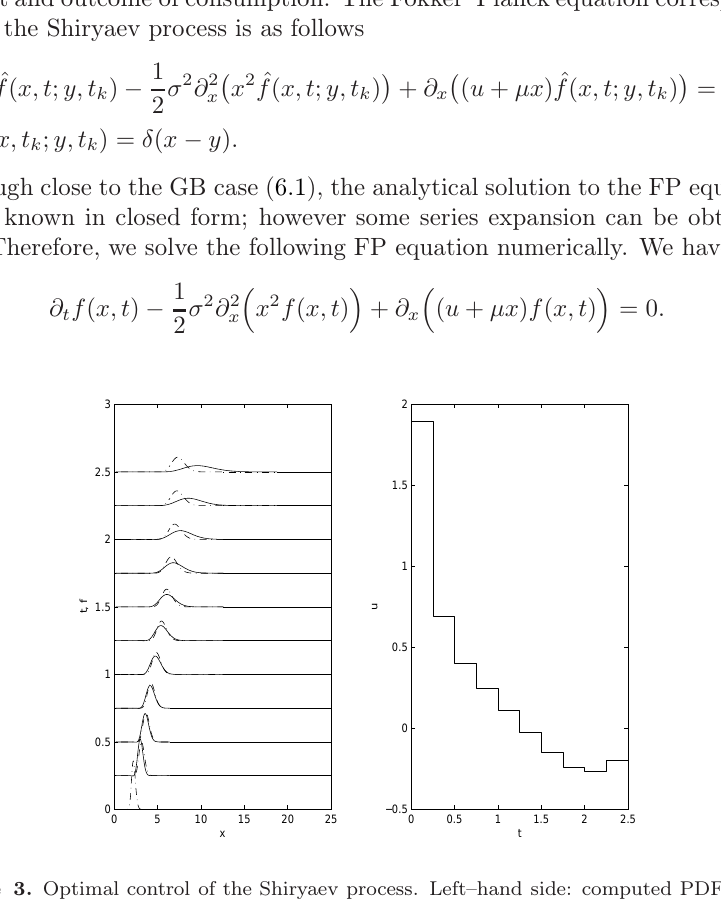
Figure 3. Optimal control of the Shiryaev process. Left–hand side: computed PDF (solid line) and desired PDF (dotted–dashed line) at different time windows. Right–hand side: optimal control